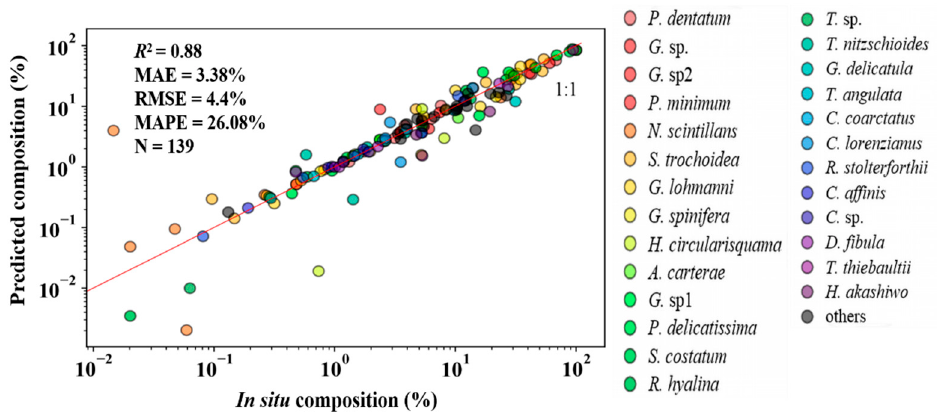
Figure 7. In situ versus NN TL -predicted compositions (%) of the 26 species in the validation dataset (Section 2.1).